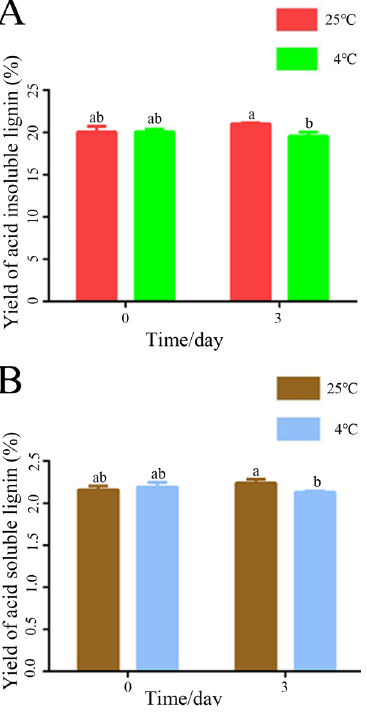
Figure 1. Cold treatment changed the content of lignin in poplar. ( A ) Yield of the content of acid insoluble lignin of the poplar stems after treatment with 4 ◦ C (cold treatment) and 25 ◦ C (normal treatment). ( B ) Yield of the acid soluble lignin content of stem in poplar after treatment with 4 ◦ C (cold treatment) and 25 ◦ C (normal treatment). The same letter on the P 0.05 level indicates that there was no difference, while a different P 0.05 level showed differences. The data are shown as the mean ± SE from three replicates. a and b represent significant differences, while ab and a, or ab and b, are not significantly different in both pairs because they have duplicate